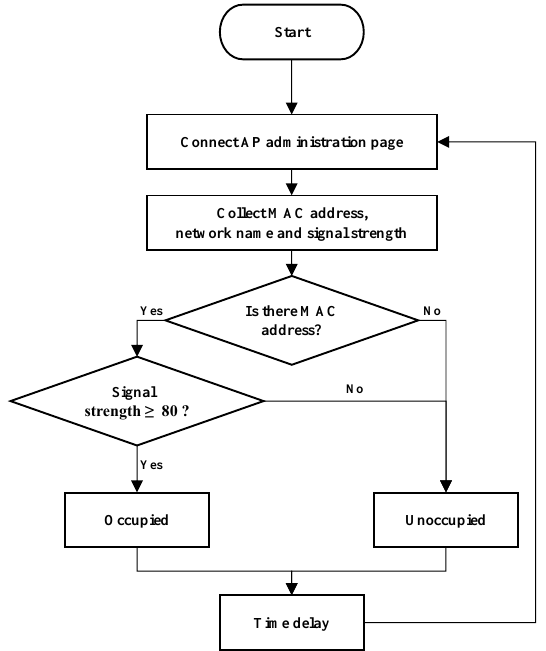
Figure 6. Occupant presence check algorithm.